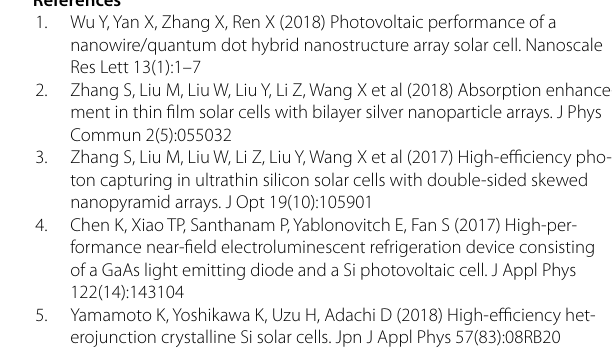
Fig. 6 Reflectance of GaAs substrate under different oxygen flow